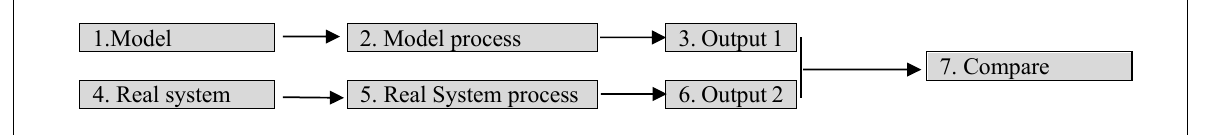
Fig. 2. Validation of The